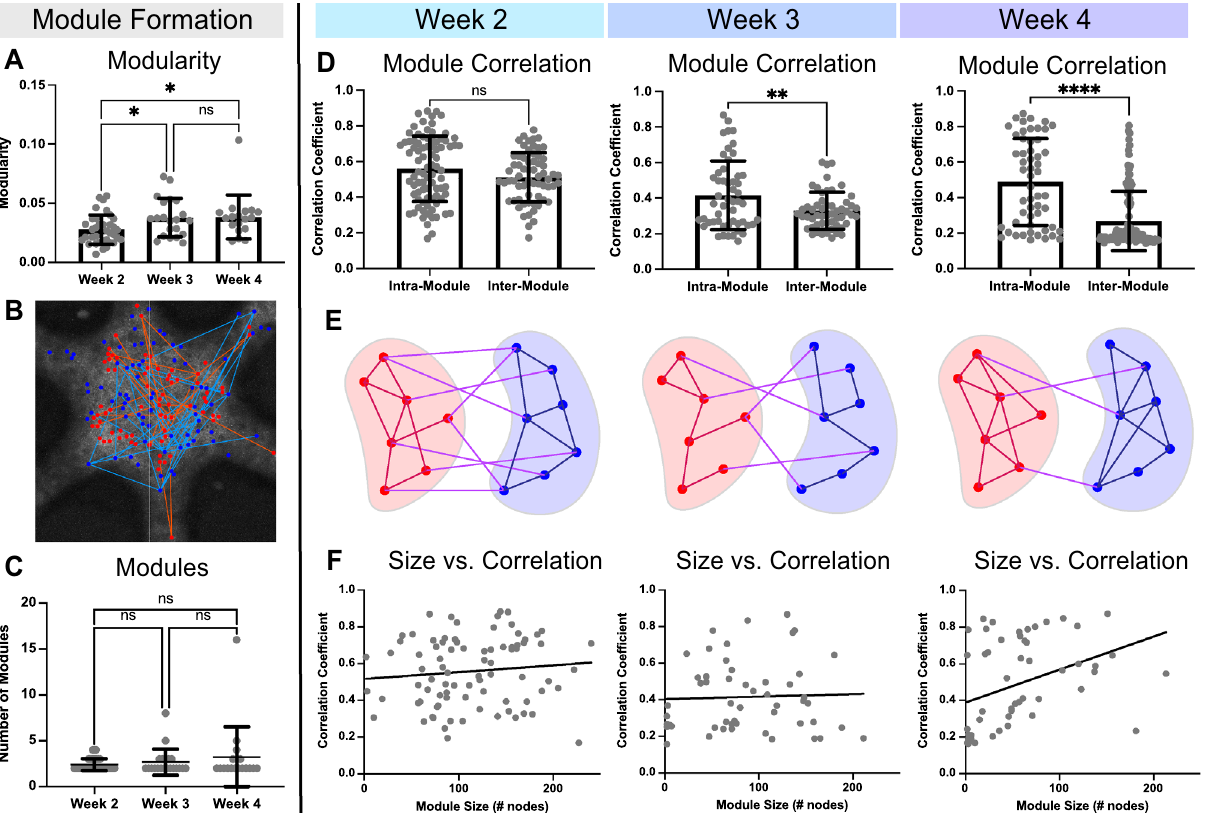
Figure 4. Microtissues develop community structure through selective functional remodeling. ( A ) Overall modularity of microtissues significantly increased ( p = 0.046) at week 3 and remained increased ( p = 0.0475) at week 4. ( B ) Representative image of the physical layout of module nodes. Module 1 nodes (red dots) and their intra-modular connections (orange lines) are physically interspersed with module 2 nodes (blue dots) and their intra-modular connections (light blue lines). ( C ) Number of modules present in microtissues does not change over the first 4 weeks of development. ( D ) The intra-module correlation is not significantly different ( p = 0.0834) from the inter-module correlation in week 2. In weeks 3 and 4 the intra- and inter- module correlations significantly separated (week 3, p = 0.0045; week 4, p < 0.0001). ( E ) Schematics of community structure formation based on data from ( D ), with intra-modular connections in red (module 1) or blue (module 2), and inter-module connections in magenta. Week 2 reflects that there was no difference between the intra-module and inter-module connections. The week 3 schematic depicts the overall decrease in functional connectivity, which disproportionately affects inter-module connection. The week 4 schematic shows the overall increase in connectivity, with an increase in intra-module connections and a decrease in inter-module connections. ( F ) There is little correlation between module size (number of nodes) and the intra-module correlation at week 2 and week 3. At week 4 there is a small positive correlation between module size and average correlation, indicating that large modules in week 4 were functionally more connected. Significance for modularity and number of modules across multiple weeks were determined with a one-way ANOVA and post-hoc Tukey test with p < 0.05 (* p < 0.05). Significance between intra-modular and inter-modular correlations were determined with unpaired, two tailed t-tests with p < 0.05 (** p < 0.01, *** p < 0.001, **** p <